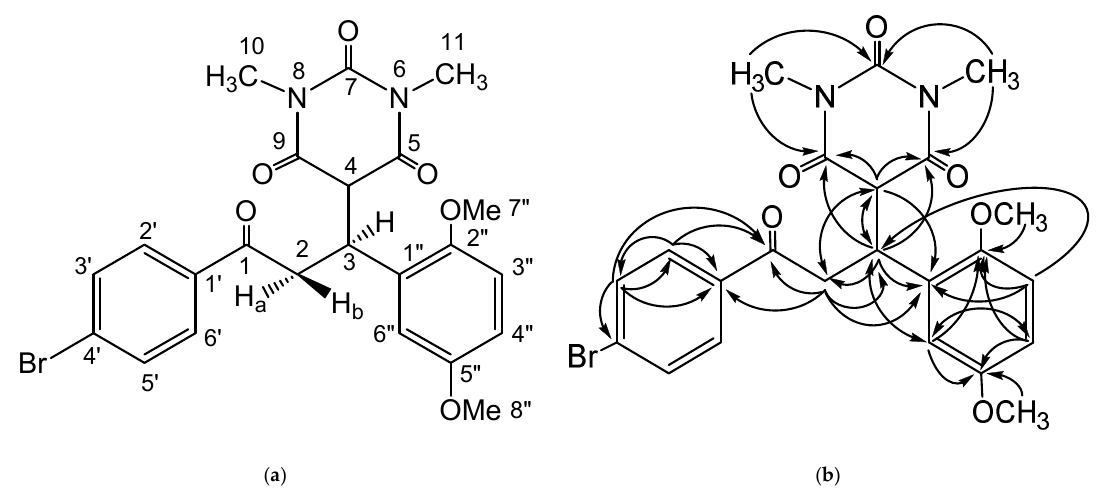
Figure 2. ( a ) Structure numbering, and ( b ) HMBC correlations of the prepared compound .